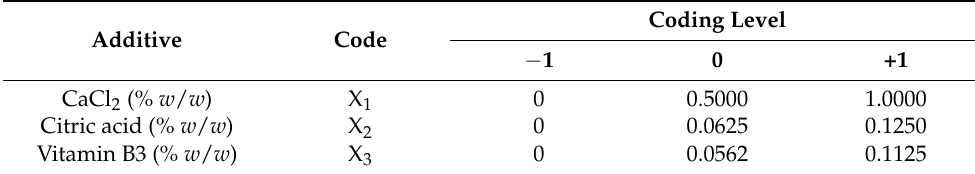
Table 4. Additives, their levels, and